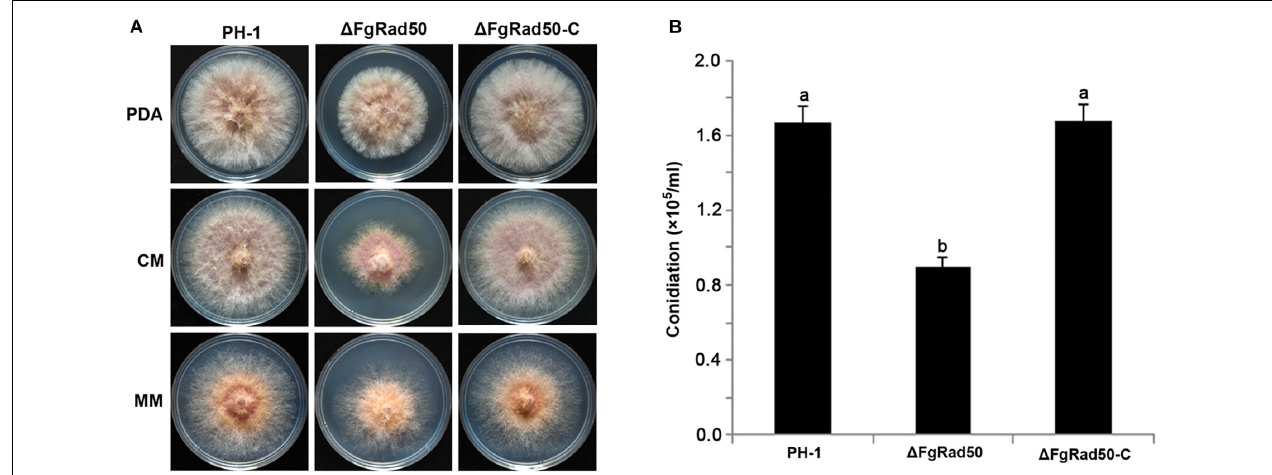
FIGURE 2 | Effect of FgRad50 deletion on mycelial growth and conidiation in F. graminearum. (A) WT PH-1, deletion mutant (cid:49) FgRad50, and (cid:49) FgRad50-C complemented strains were grown on potato dextrose agar (PDA), complete medium (CM), and minimal medium (MM) at 25 ◦ C for 3 days. (B) Conidia were quantified after incubation of WT PH-1, deletion mutant (cid:49) FgRad50, and complemented (cid:49) FgRad50-C strains in 30 mL of carboxymethyl cellulose (CMC) liquid medium at 25 ◦ C with shaking at 180 rpm for 4 days. Bars denote standard deviations from three repeated experiments. The same letter on the bars for each treatment represents no significant difference at P = 0.05.